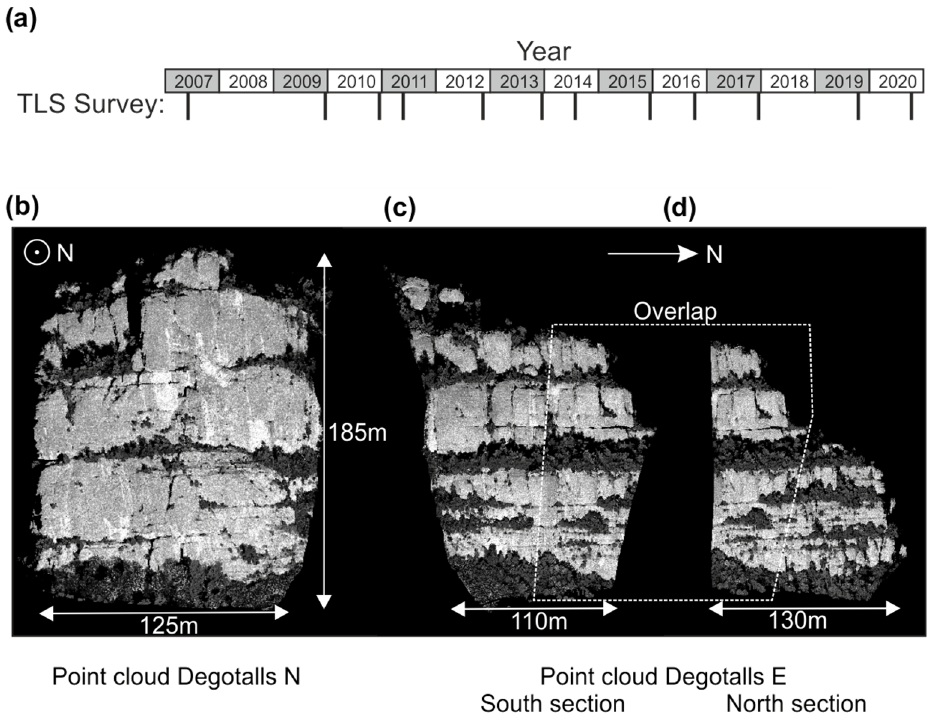
Figure 8. ( a ) Time series relating to the TLS surveys in the Degotalls area. All TLS acquisition were conducted with the same device from two stations (Degotalls N and Degotalls E). The survey also included high-resolution images to validate data. ( b ) Point cloud of the Degotalls N cliff: 2,370,000 points. Station 1 ( c ) South section point cloud of the Degotalls E cliff: 2,860,000 points. Station 2, orientation 1 ( d ) North section point cloud of the Degotalls E cliff: 2,060,000 points. Station 2, orientation 2 (re-orientation of the scanner). Point clouds and figures correspond to the texture intensity of the TLS returned signal (1530 nm).